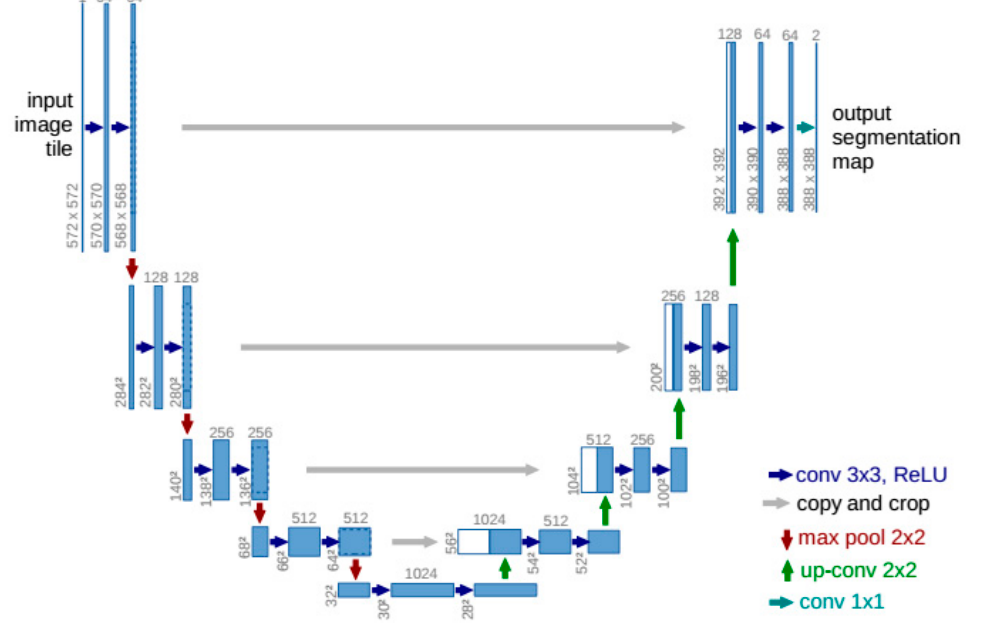
Figure 6. The network structure of UNet.